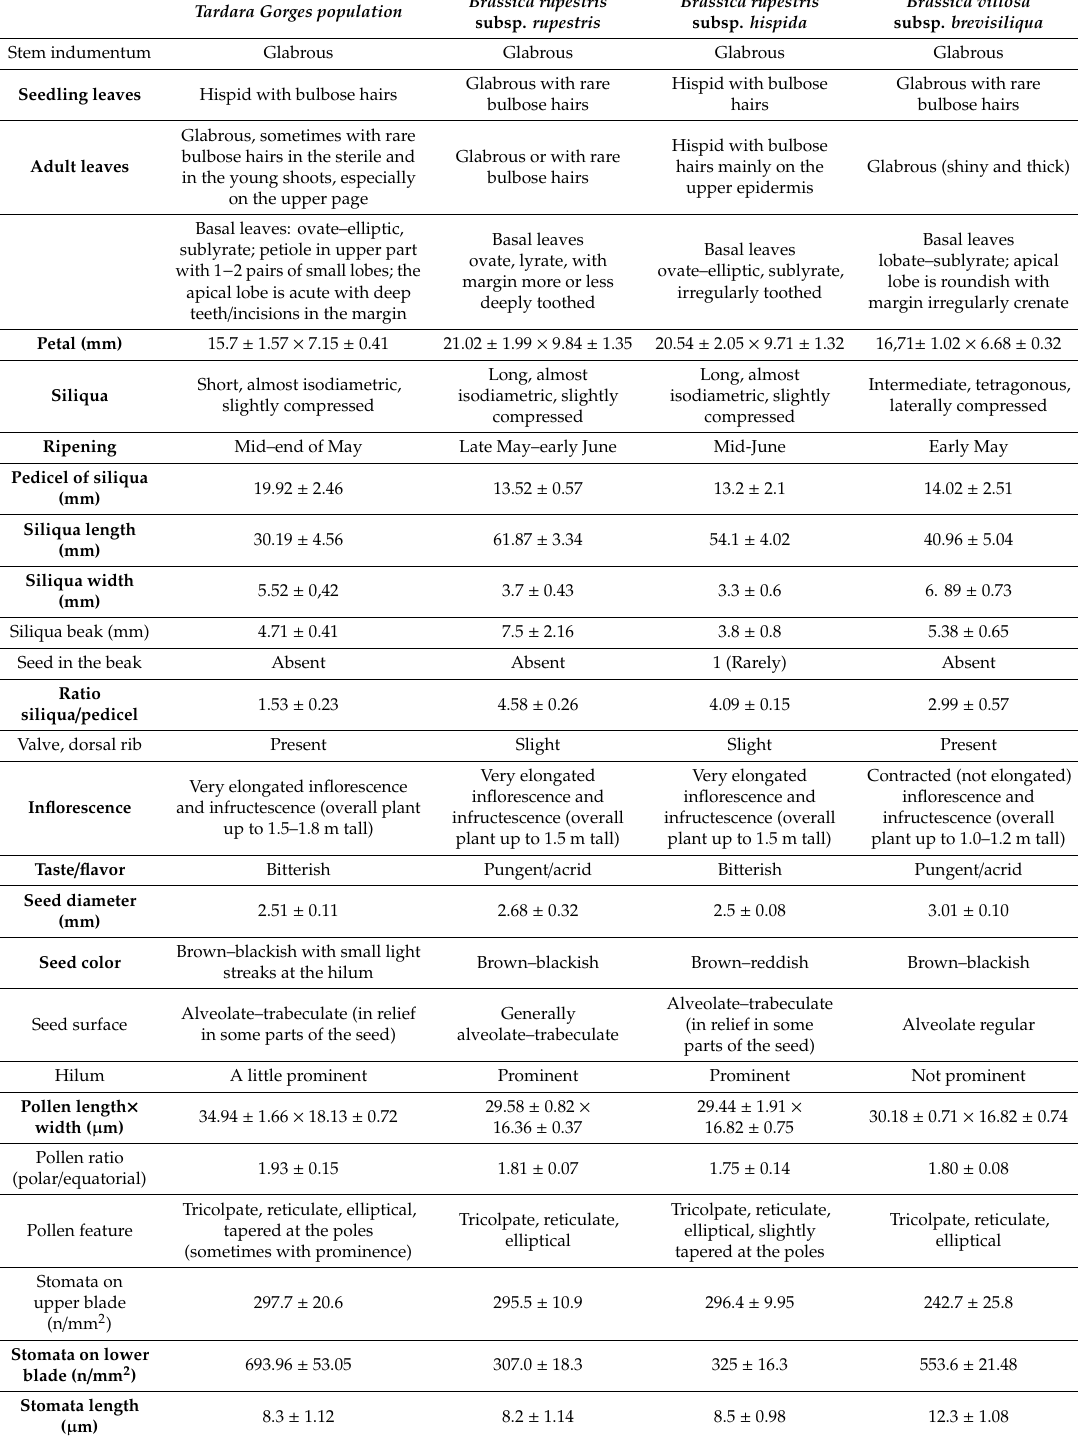
Table 1. Main features of the studied Tardara Gorges Brassica population compared with those of most similar taxa. Main diagnostic characters are in bold. Mean values ± S.D. (where